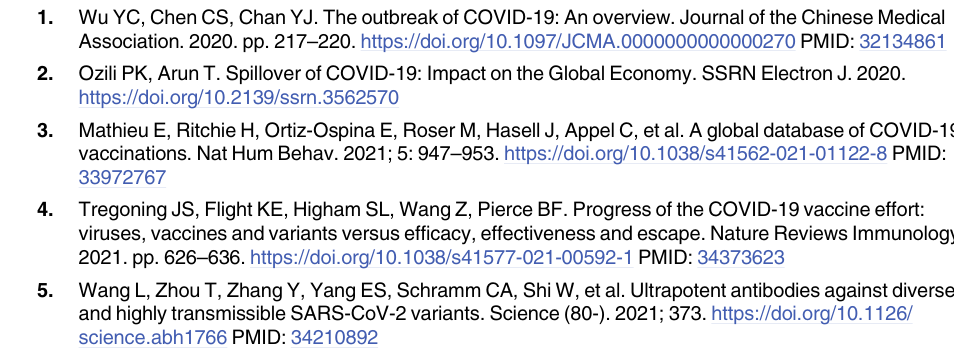
S1 Table. Details on amino acid composition and effects of mutations on the physicochem- ical, structural, functional and binding properties of the spike protein. S2 Table. Detail effects of the mutations on antigenicity, immunogenicity, pro-inflamma- tion and anti-inflammation properties of the epitopes predicted for B-cell, CD4+ T-cell and CD8+ T-cell mediated